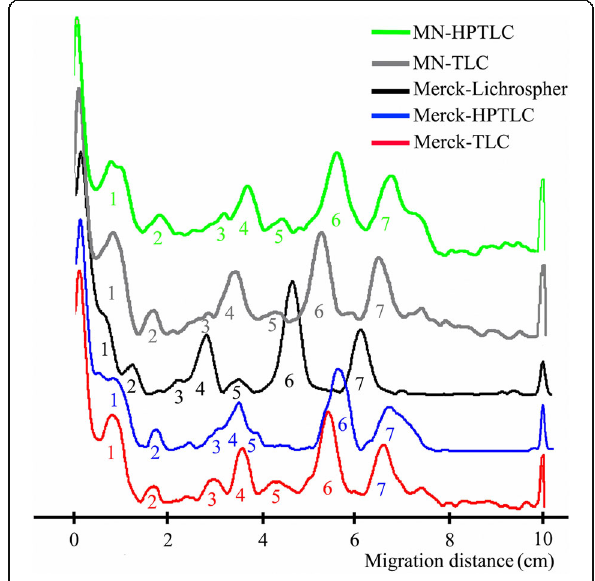
Fig. 3 Concurrent representation of densitograms obtained from separation of opium alkaloids on